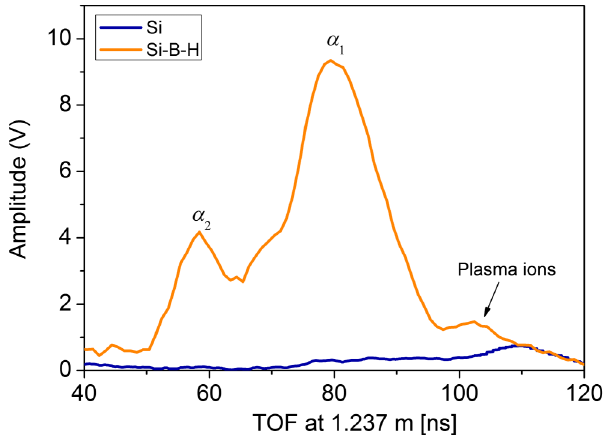
FIG. 6. Ion TOF distribution for the Si-H-B target (orange curve) with the alpha-particle signal ( α 1 and α 2 ) and plasma ions measured by the SiC detector covered by a 8 - μ m aluminum foil and placed at 65° with respect to the target normal. The ion TOF distribution for the Si target (blue curve) showing the presence of only plasma ions (no fusion event has occurred) is also reported for comparison.